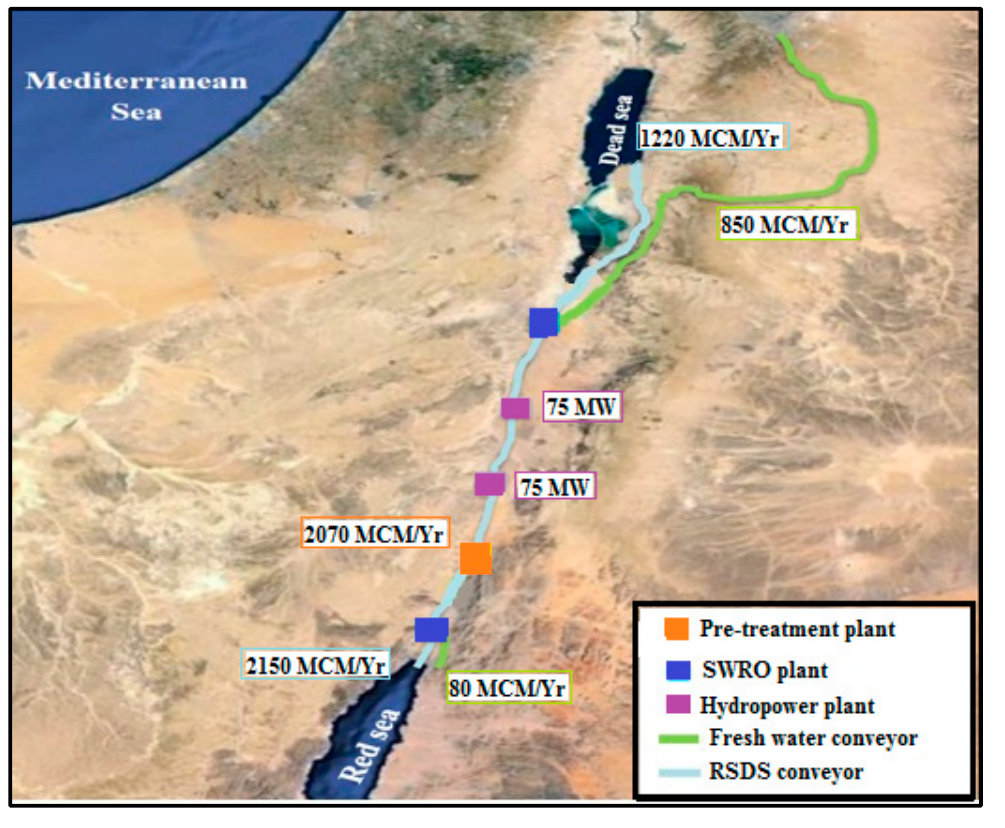
Figure 2. Schematic of Red Sea—Dead Sea Conveyance Project and amounts of annual flow rates.